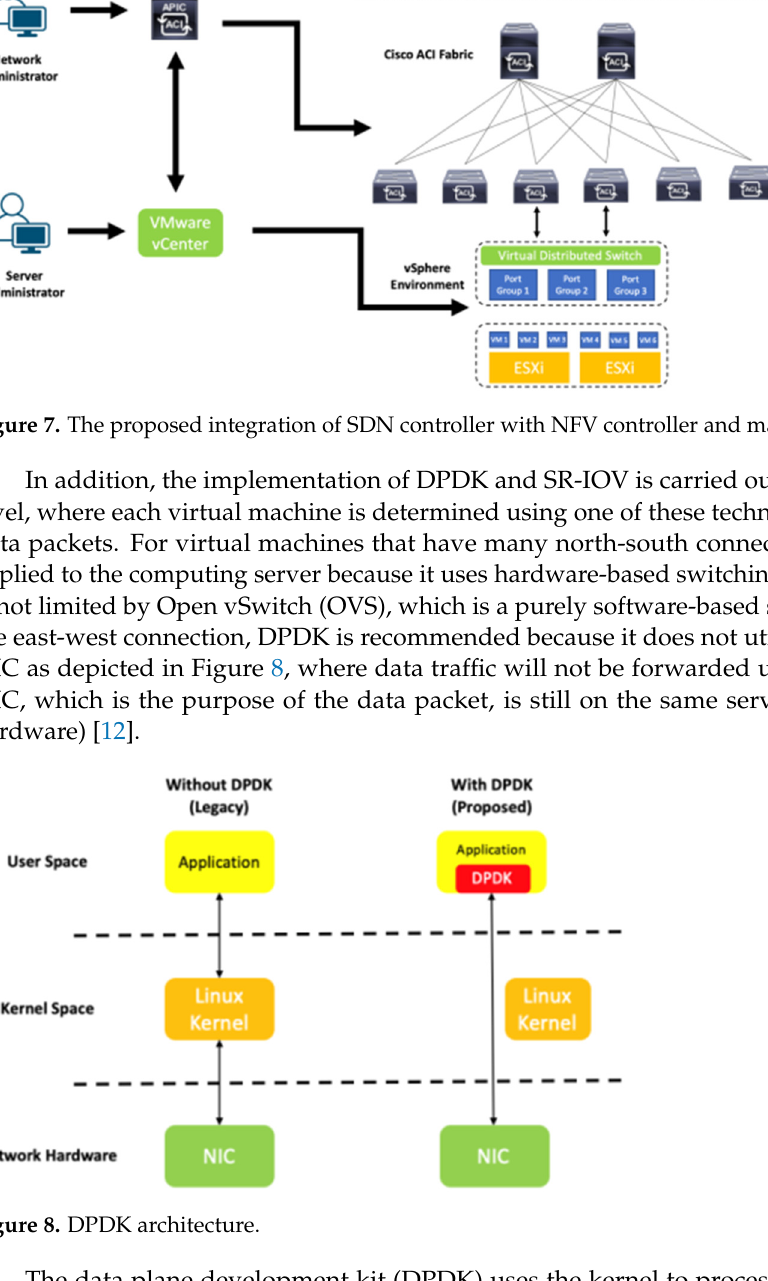
Figure 6. Logical design of SDN and NFV.